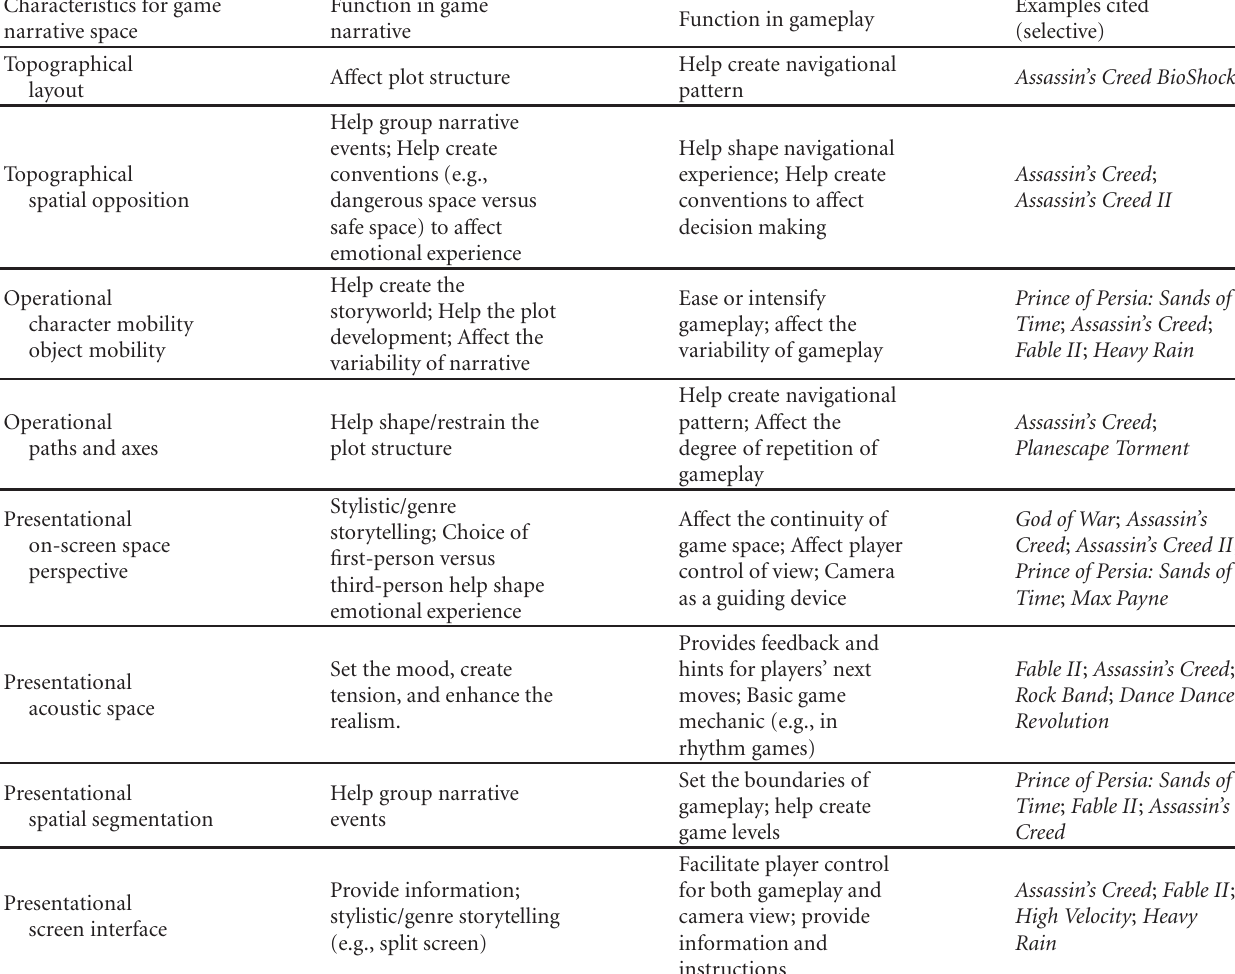
Table 2: Summary of spatial characteristics discussed that a ff ect narrative and gameplay